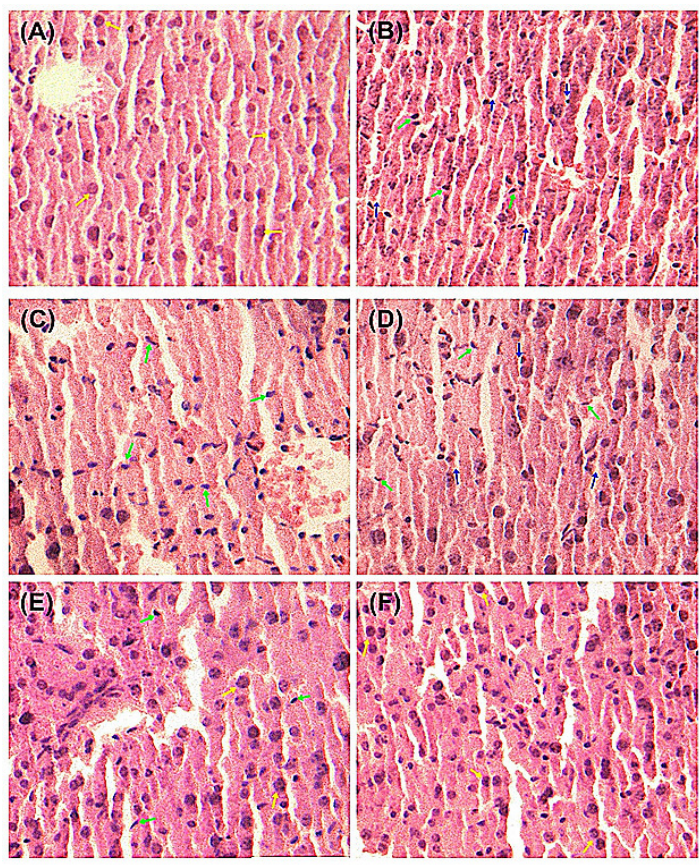
Figure 3. Pathological changes of the liver tissues in mice with the H&E staining. ( A ) Normal control. ( B ) CCl alone treatment. ( C ) CCl treatment and administration of 4 4 quercetin (Que) at 200 mg/kg·bw, ig. ( D ) CCl treatment and administration of QS at 4 treatment and administration of Que at 500 mg/kg·bw, ig. 200 mg/kg·bw, ig. ( E ) CCl 4 ( F ) CCl treatment and administration of QS at 500 mg/kg·bw, ig. The green arrow indicates 4 hepatic cell necrosis and the nucleus contraction. The blue arrow indicates the enlarged sinusoids between the plates of hepatocytes and loss of cellular boundaries. The yellow arrow indicates normal cellular architecture with clear hepatic